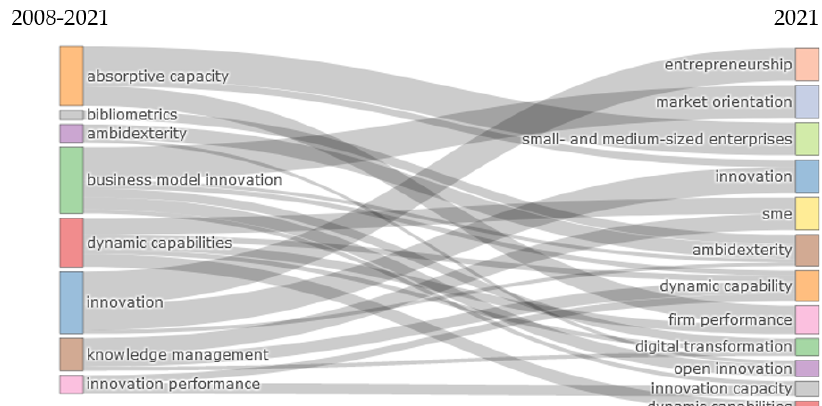
Figure 6. Thematic evolution. Source: Scopus/Biblioshiny.